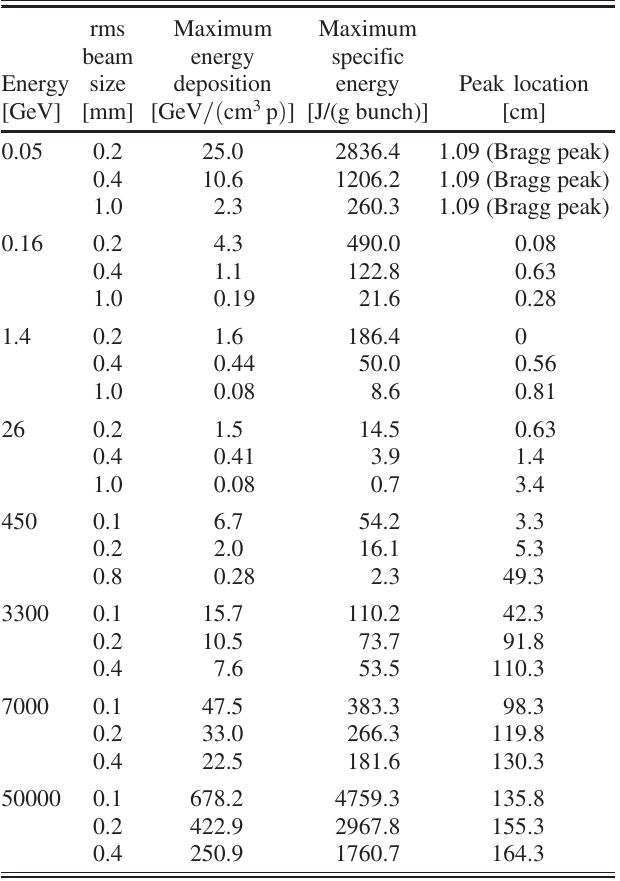
TABLE VI. Summary of the energy deposition of protons in a solid graphite target with typical beam